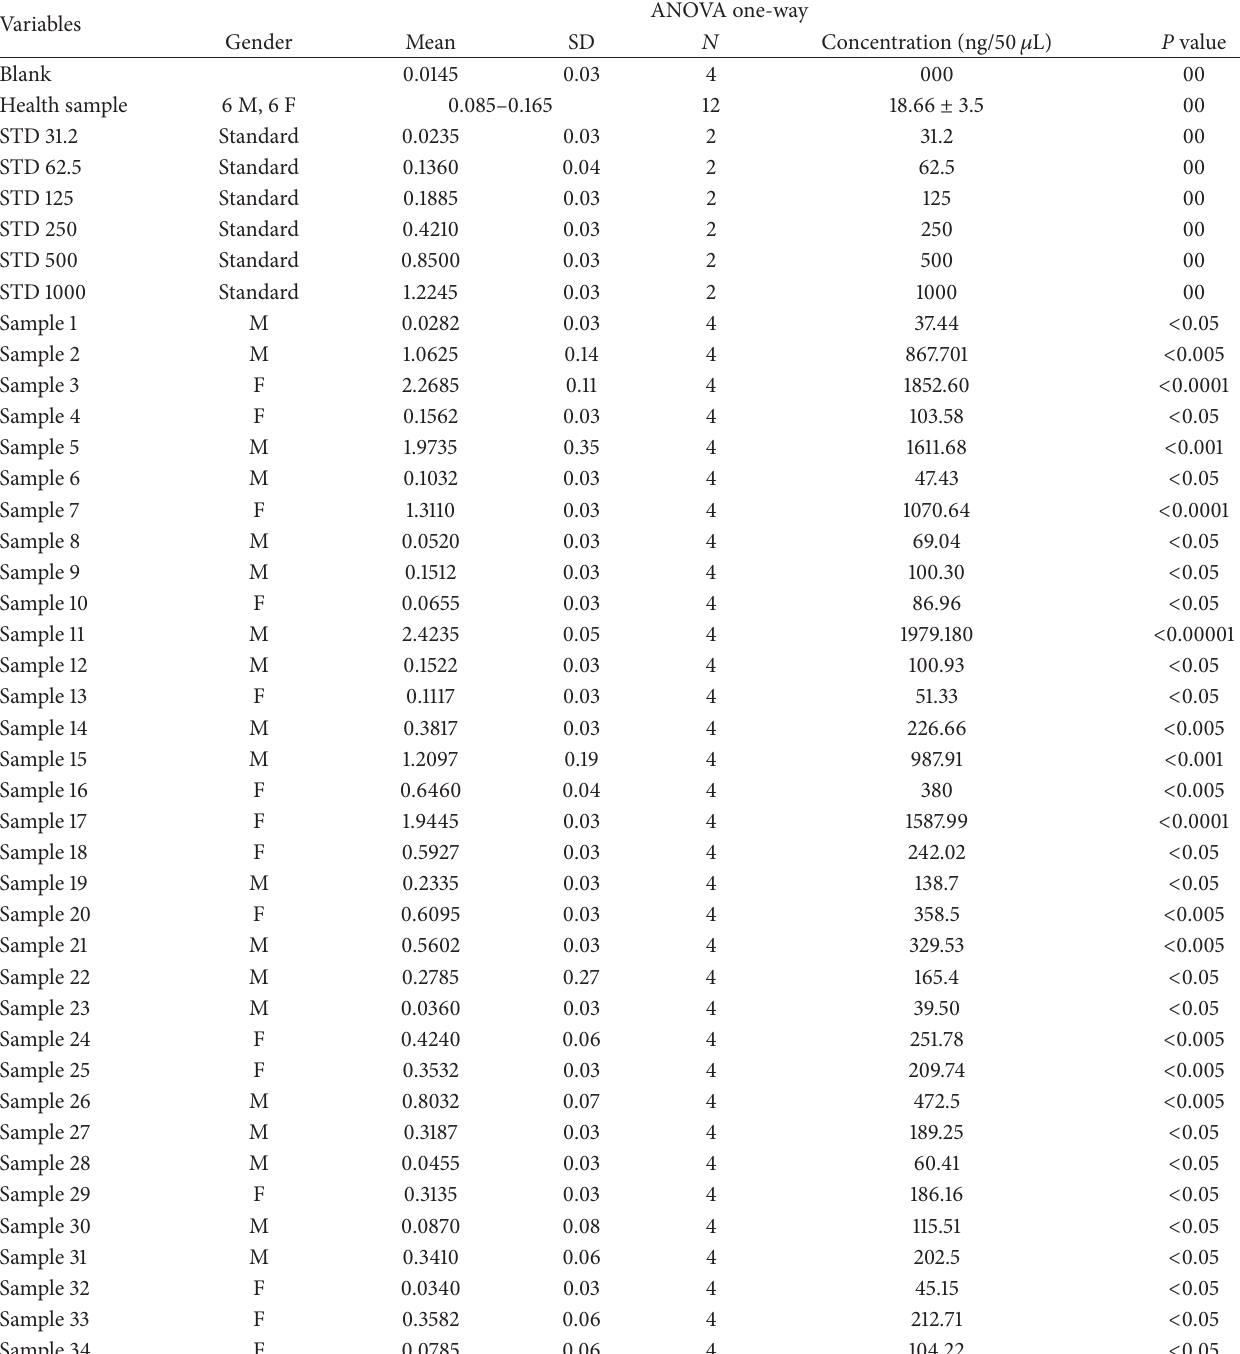
Table 1: Total human defensin concentration in HCV patients